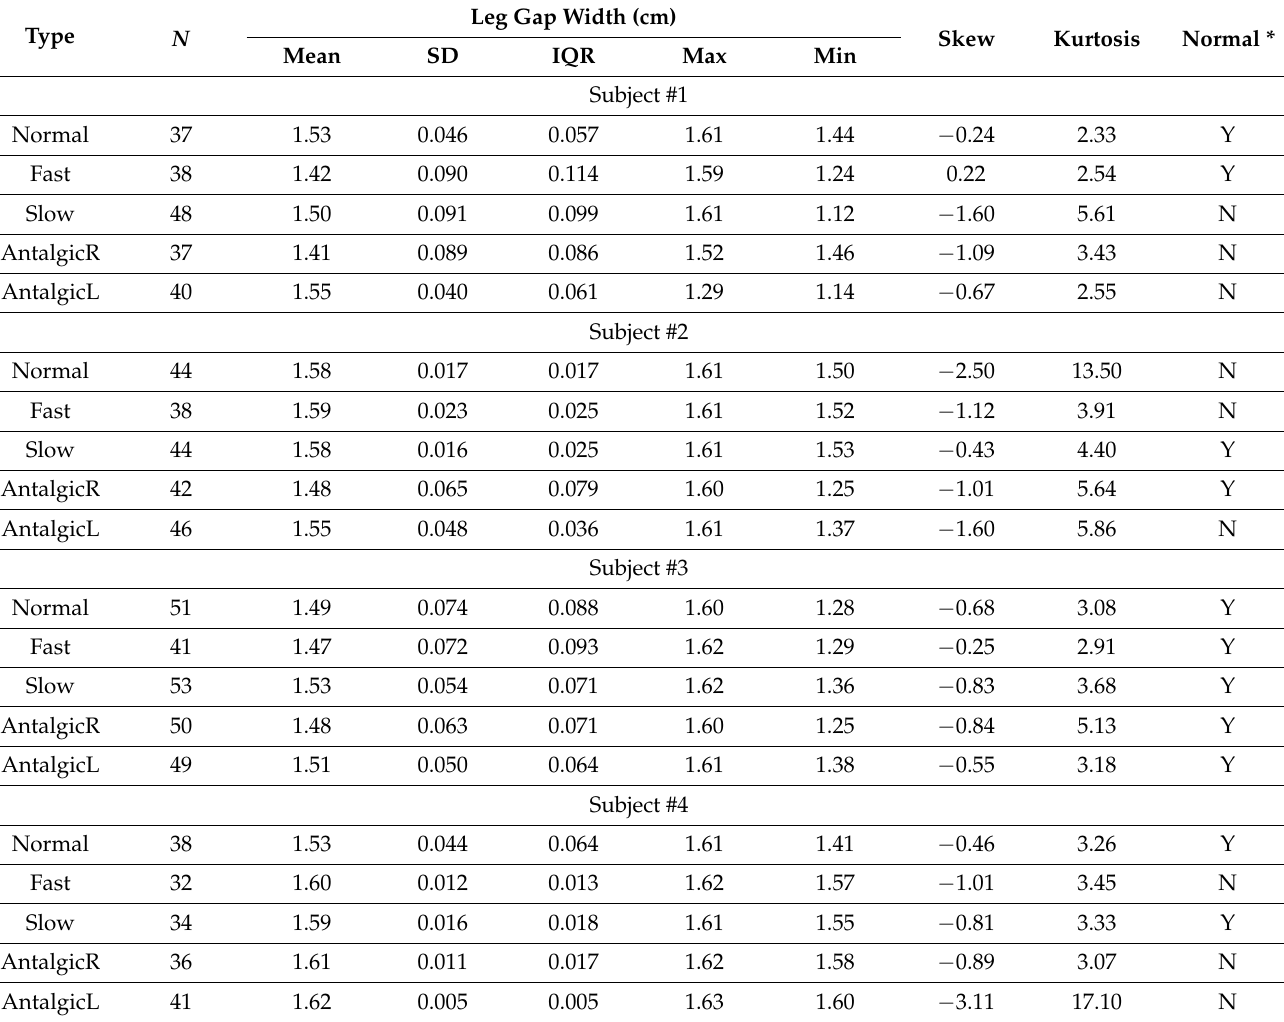
Table 5. Descriptive Statistics and Normality of Leg Gap